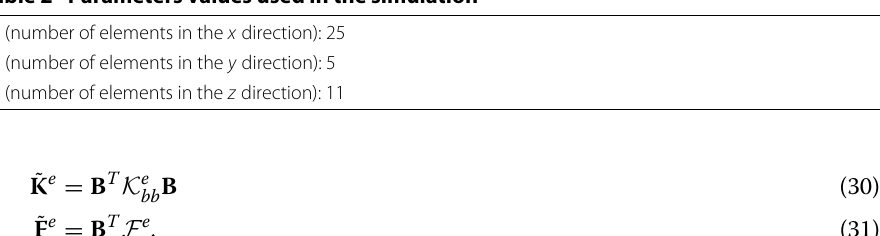
Table 2 Parameters values used in the